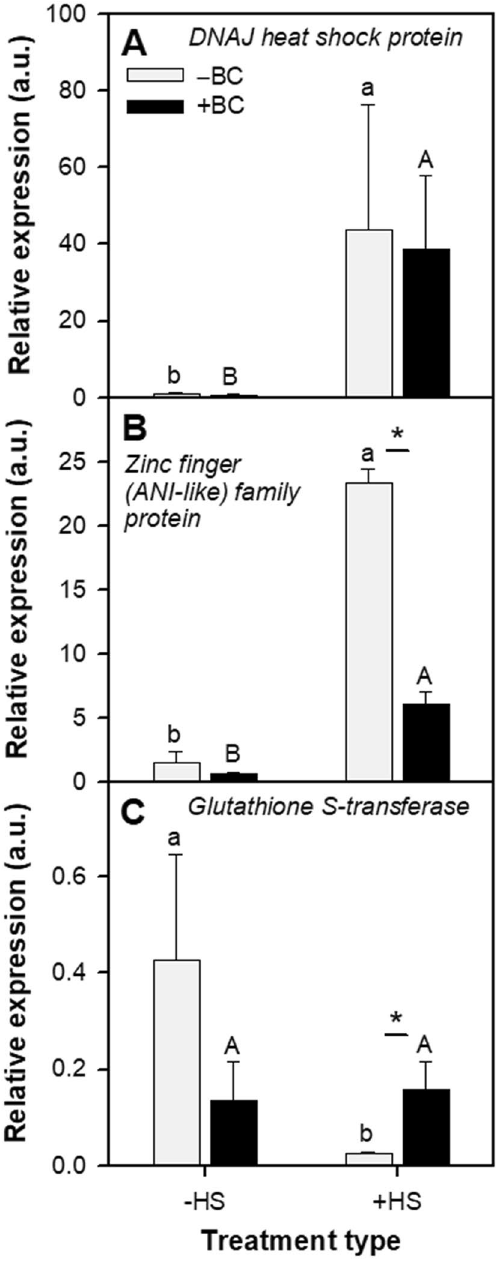
of Arabidopsis thaliana in ‒ HS and + HS conditions at 21 days. ( A ) DNAJ heat shock protein ( Hsp40 ); ( B ) Zinc finger ( ANI-like ) family protein ( ZnF ) and ( C ) glutathione S-transferase ( GST ). Data are representative of two repeated experiments. Columns represents the mean value (n = 3) and range (calculated by evaluating using ΔΔCT ± S.E.) 103